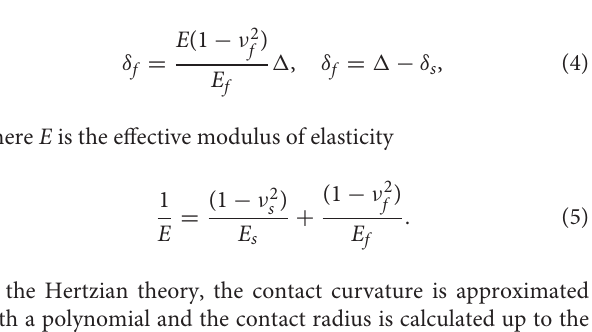
0.0042 to 1/ R 0.05 = =